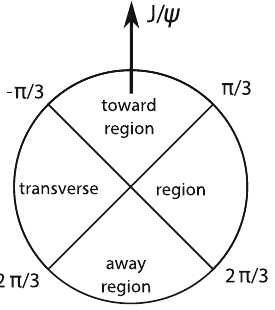
Fig. 9 Definition of the Toward, Transverse and Away region in ϕ with respect to the J /ψ direction